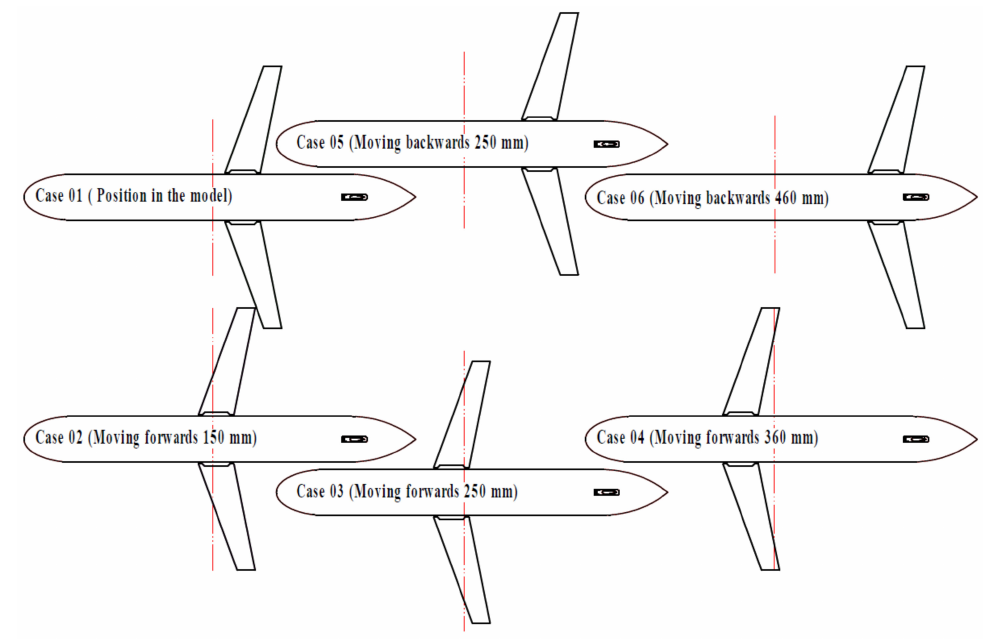
Figure 5. Schematic diagram of relationship between fixed wing and buoyancy center position.